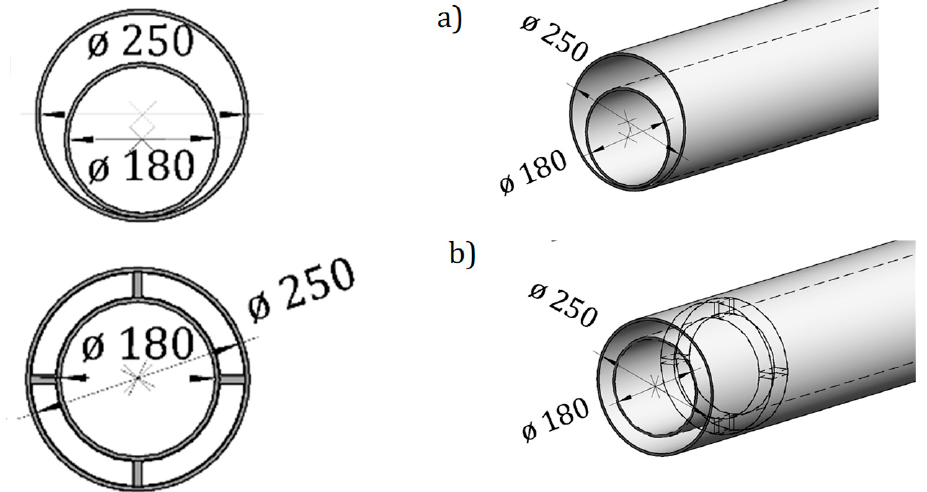
Figure 14. A look at a real installation of a pipe-in-pipe heat recovery air exchanger and the innovative solution with spacer rings [2,20]. ( a ) pipe in a pipe without the use of spacer rings, ( b ) pipe in a pipe with the use of spacer rings.